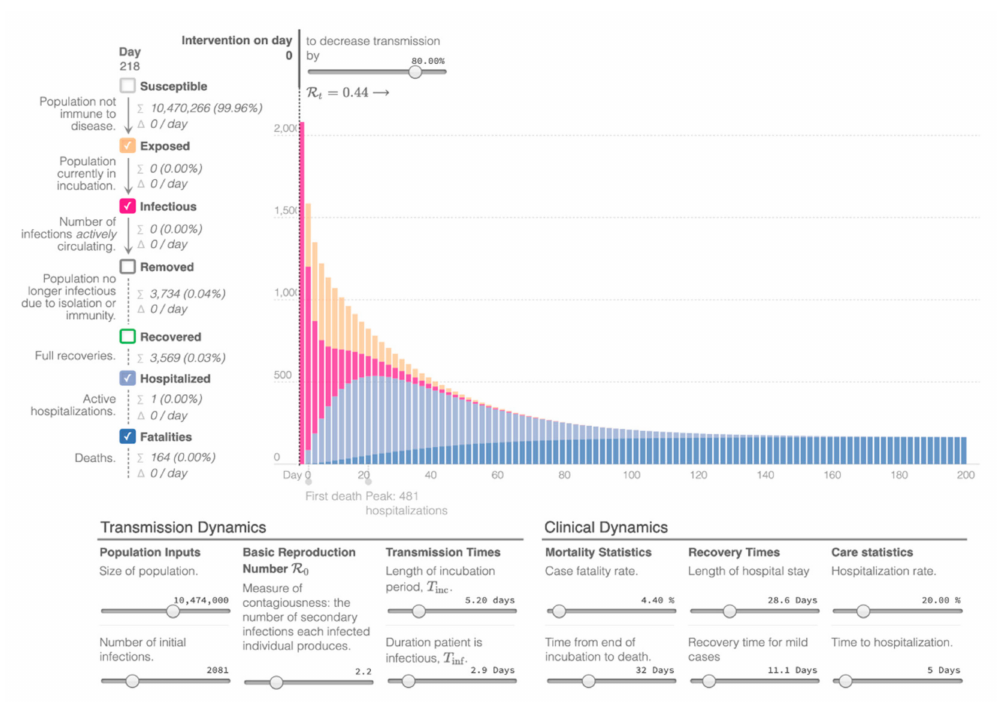
Figure 3. Epidemiological Curve